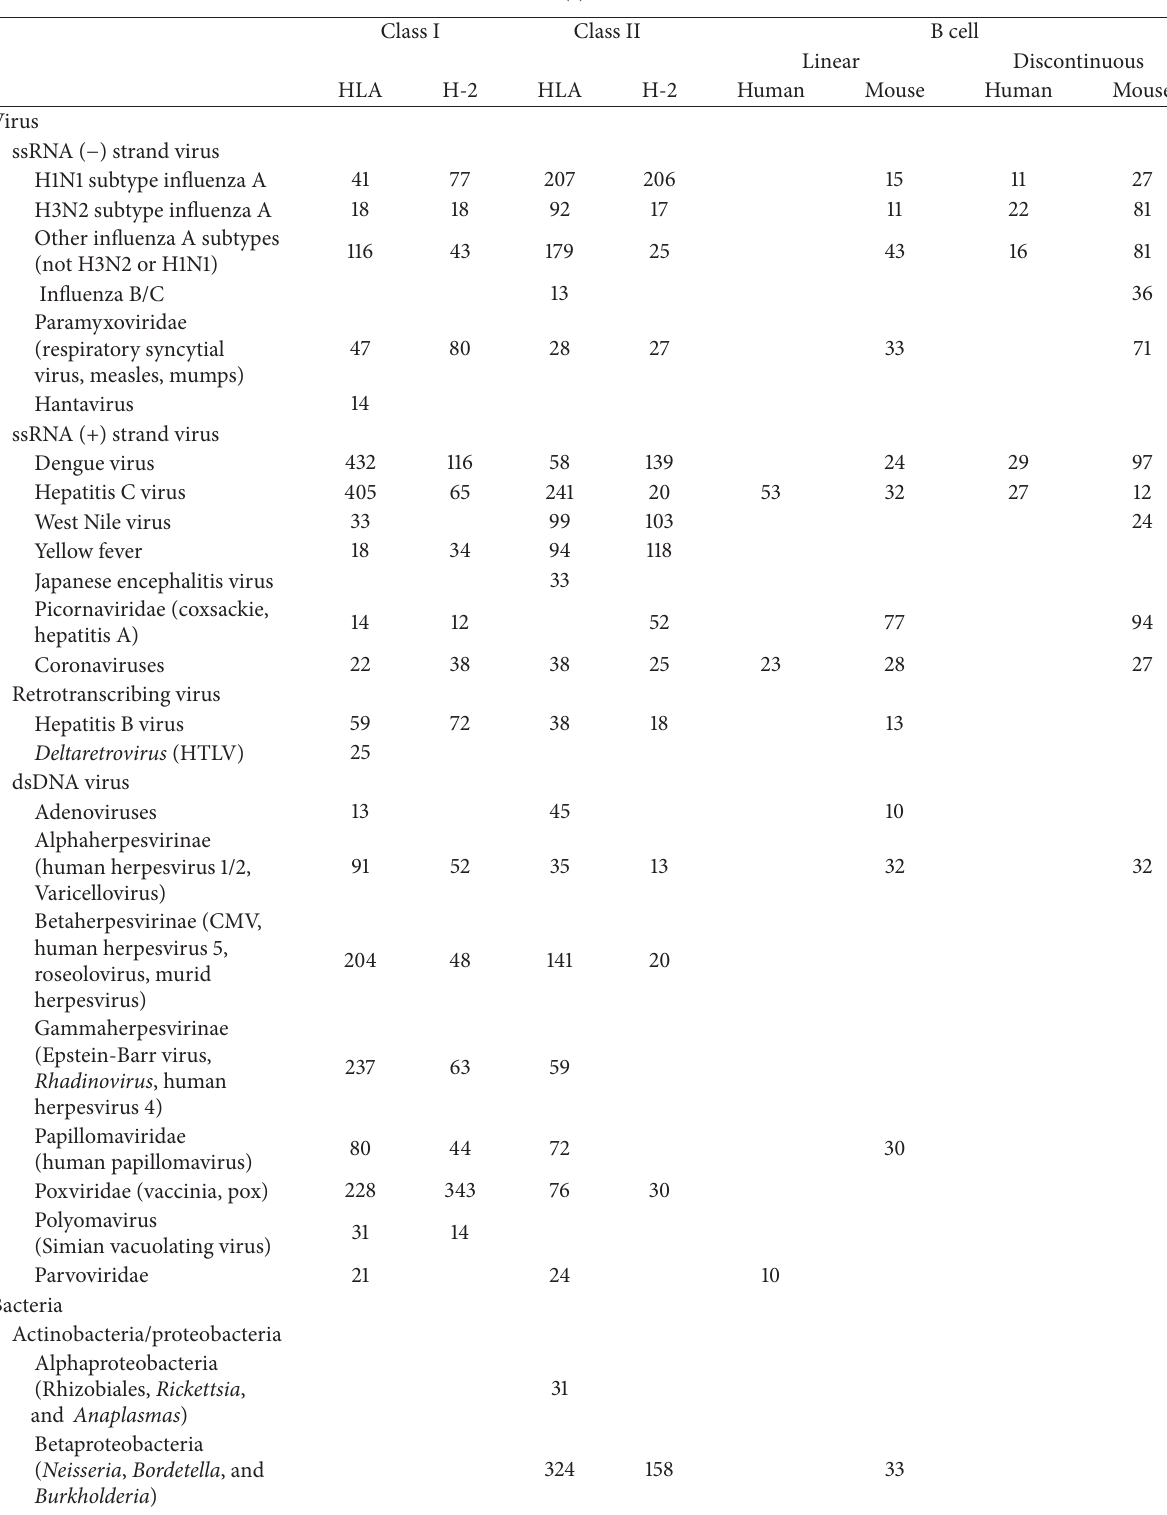
Table 2: (a) Number of epitopes per category for viruses and bacteria. (b) Number of epitopes per category for eukaryotes (nonhuman). (c) Number of epitopes per category for autoimmune epitopes (human and